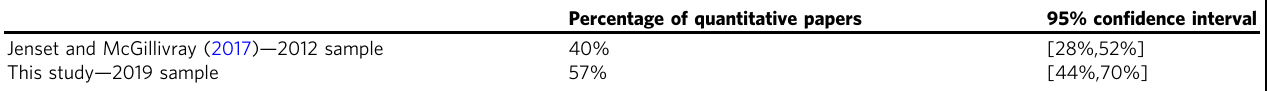
Table 2 95% con fi dence intervals for the percentage of quantitative papers in the 2012 study (Jenset and McGillivray, 2017) based on a sample of historical linguistics articles published in 2012 and in this study using a sample of articles published in